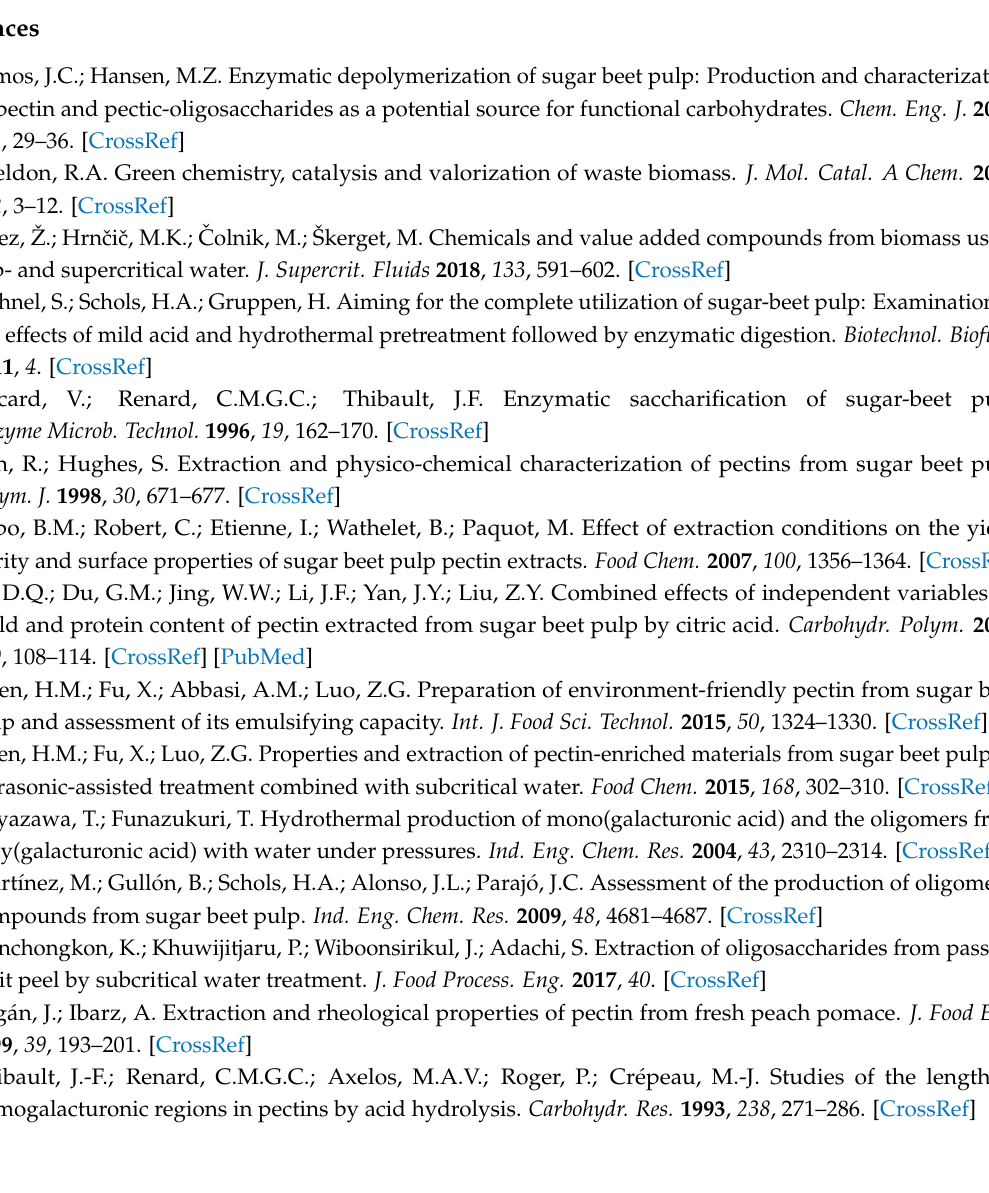
Supplementary Materials: The following are available online: Table S1A. Standard deviations of the coefficients of the quadratic models calculated for the pectin yield ( YP ) (Equation (3)) and for the sum of neutral monosaccharides yield ( Y NS ) (Equation (4)); Experimental validation - pectin yield ( Y ): Table S2A. Analysis of variance: response Y; Table S3A. Estimates of the coefficients: response Y; Table S4A. Statistics on the coefficients: response Y; Table S5A. Residuals: response Y; Table S6A. Material balances for hydrothermal extraction of pectin from 100.0 g of SBP; Experimental validation - neutral monosaccharides yield (Y): Table S7A. Analysis of variance: response Y; Table S8A. Estimates of and statistics on the coefficients: response Y; Table S9A. Statistics on the coefficients: response Y; Table S10A. Residuals: response